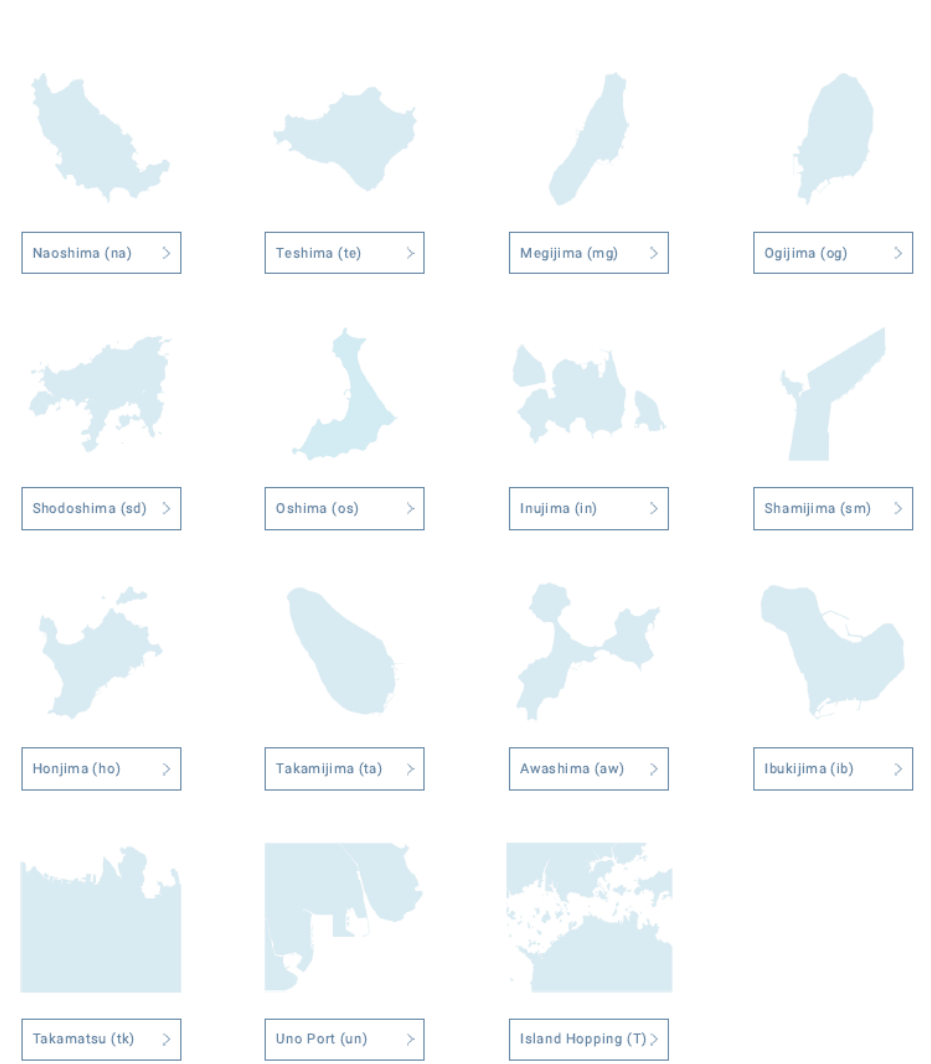
Figure 3. From pollution to green islands: the Triennale hosting areas with 12 islands and two ports. ST is hosted in 12 islands (Naoshima, Shodoshima, Teshima, Megijima, Syamijima, Ogijima, Inujima, Awashima, Honjima, Takamijima, Ibukijima, Oshima) and two ports (Takamatsu port, Uno port) in